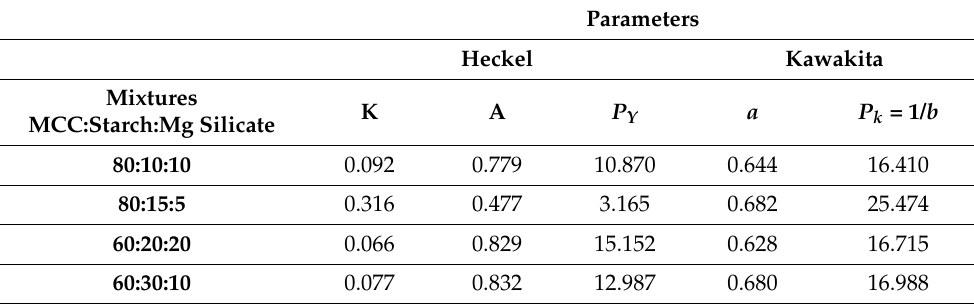
Table 5. Heckel and Kawakita parameters of ternary mixtures subjected to wet granulation and of composition near the optimum.